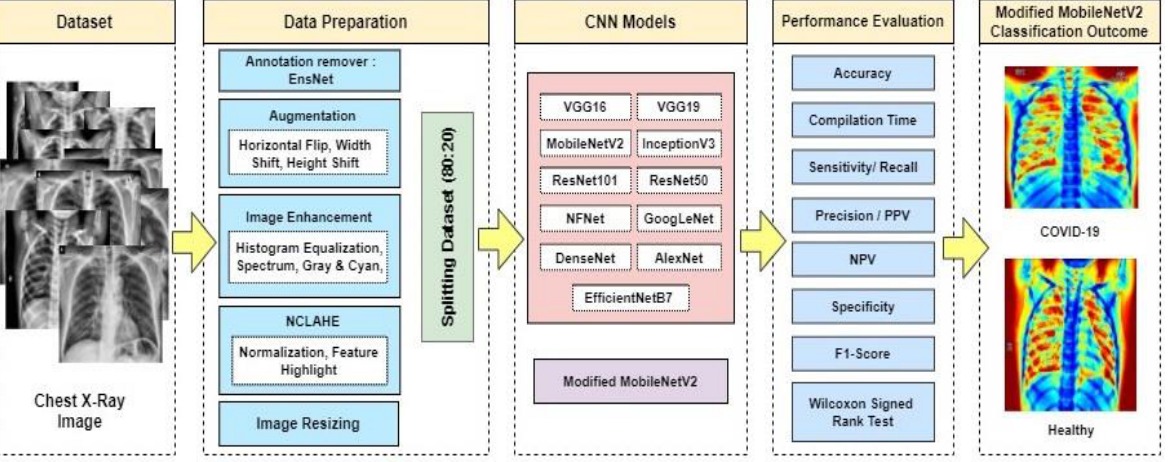
Figure 2. Proposed system diagram.